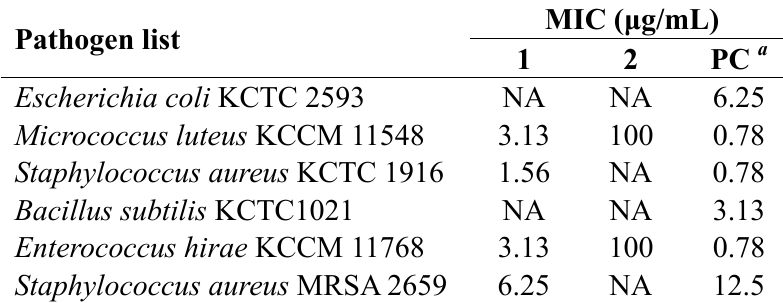
Table 2. MIC test results for 1 and 2